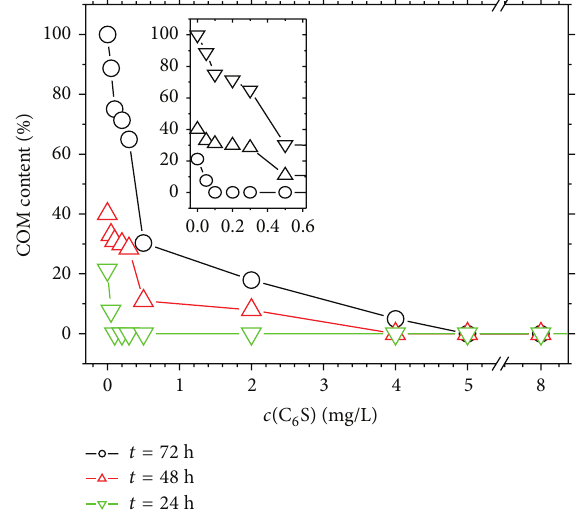
Figure 4: Effect of C 6 S concentration ( 𝑐 (C 6 S)) and acting time ( 𝑡 ) on transformation of submicron COD to